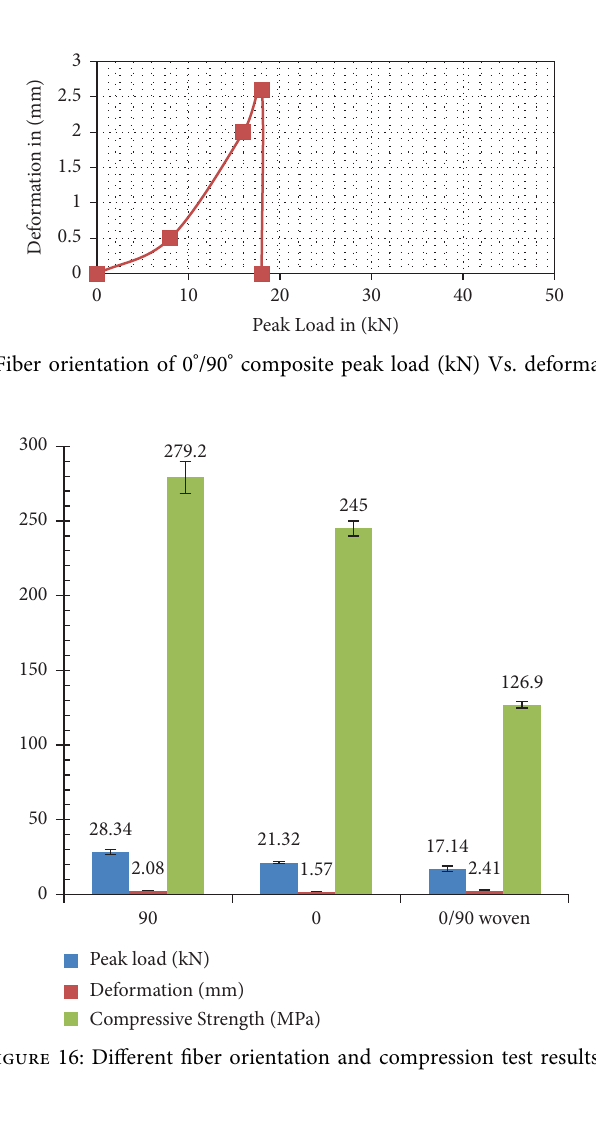
Figure 14: Fiber orientation 0 ° composite peak force (kN) Vs. deformation